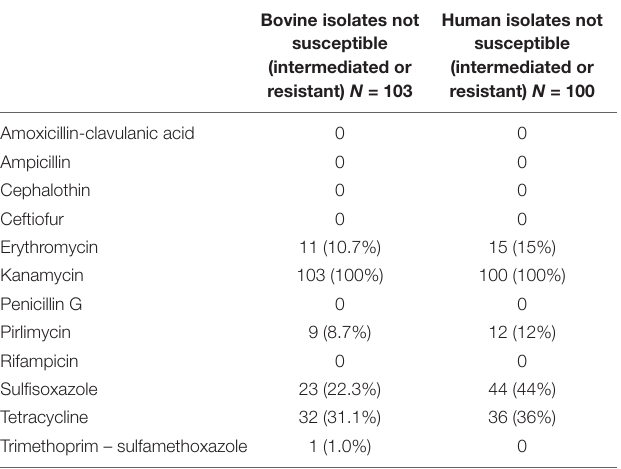
TABLE 3 | Antimicrobial susceptibility